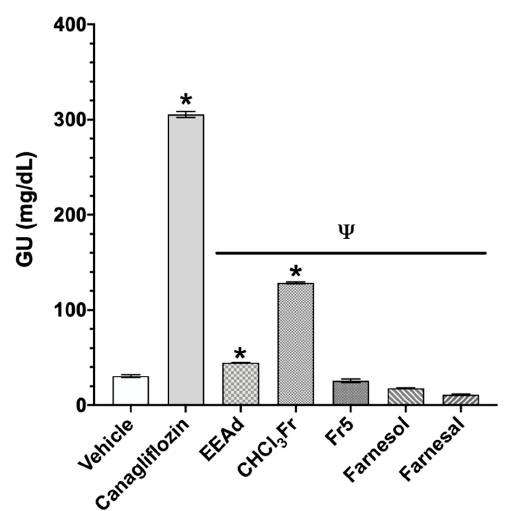
Figure 4. Effect on urinary glucose concentration after administration of products isolated from A. diversifolia and canagliflozin on the urinary glucose excretion (UGE) assay. Data are expressed as means ± SEM, n = 6; * p < 0.05 vs. vehicle; Ψ p < 0.05 vs. canagliflozin. GU: glucose in